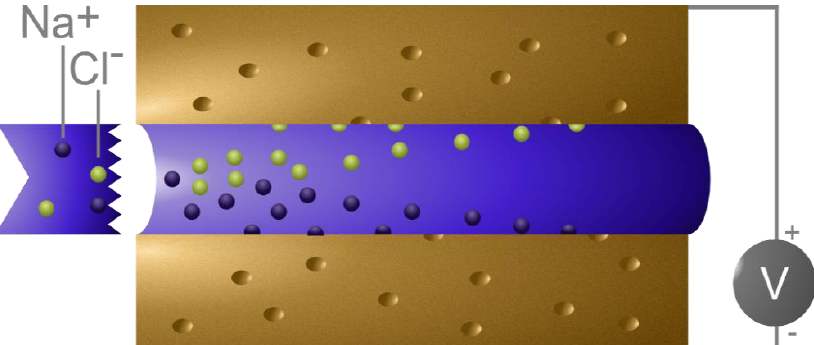
Figure 1. A schematic representation of capacitive deionization (CDI) cell typically comprising two porous electrodes separated by a spacer. When a potential is applied across the electrodes, the ions in the water flowing through such device adsorb on the electrodes.